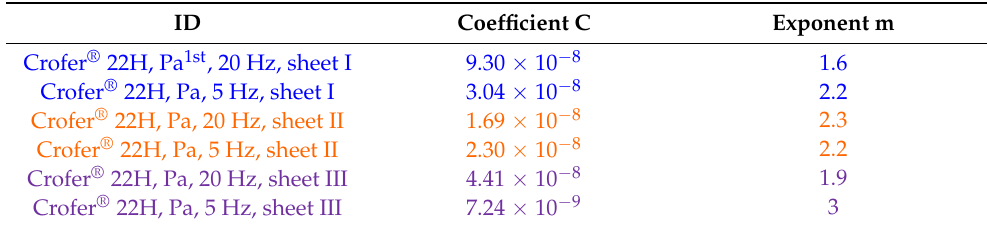
Figure 18. SEM investigations demonstrate ( a ) undesirable Nb/Ti-MX particles in Crofer ® 22H (PA) sheet I and ( b ) almost Laves phase particle-free regions within the matrix, which have no additional